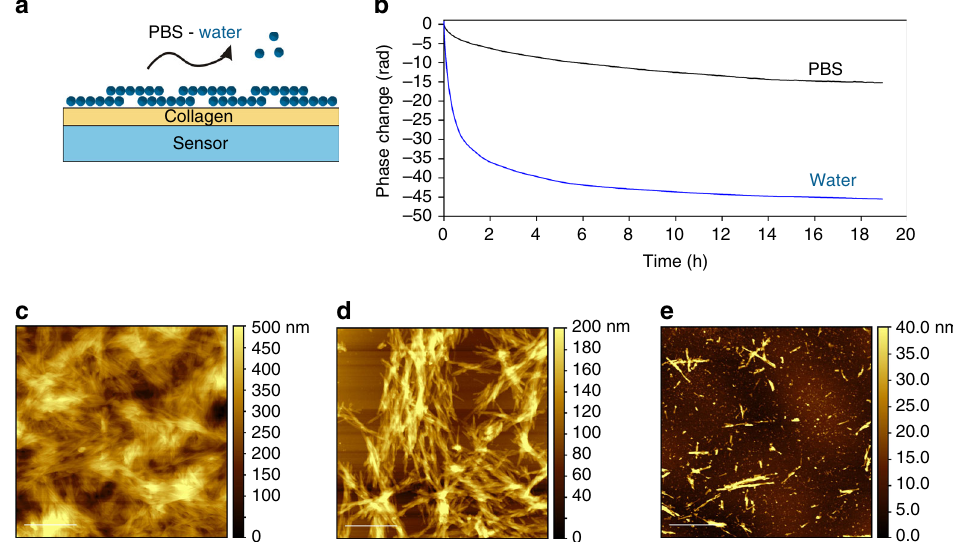
Fig. 4 Dissociation pro fi le of Oxm nano fi brils under physiological conditions. a Schematic of the dissociation study using the DPI biosensing technique. b Phase changes as a function of time on top of the DPI sensor coated with collagen and fi brillar Oxm in water (blue) and PBS (black). c – e Representative AFM images of Oxm nano fi brils deposited onto a collagen layer before c and after incubation in PBS d and water e . Scale bar, 1 μ